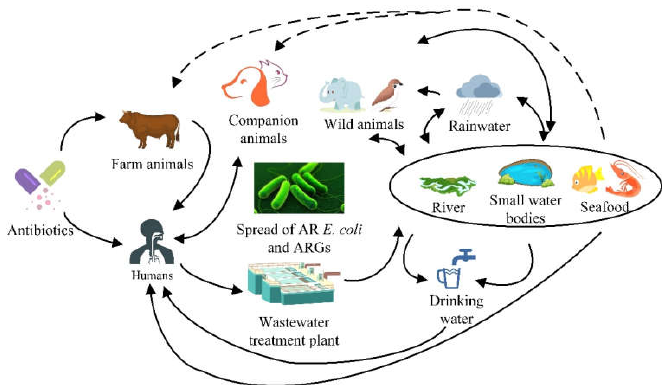
Figure 1. Multiple pathways involved in the transfer of AR E. coli and its ARGs in animals, humans, and the environment. Antibiotics used in farm animals may lead to AR E. coli , which is present in food products, feces, manure, waste, treatment plants, etc. AR E. coli and its ARGs can be transferred from farm animals to the surrounding environment, other animals, or even humans by multiple routes (including foods, waste, surface water, river, rainwater, drinking systems,